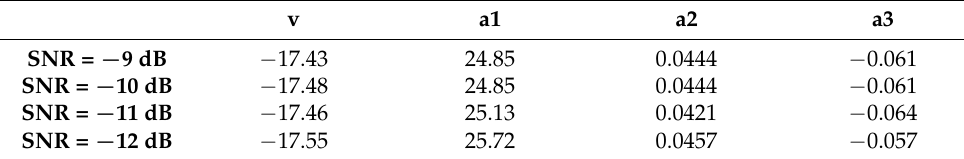
Table 2. Result of translational parameter